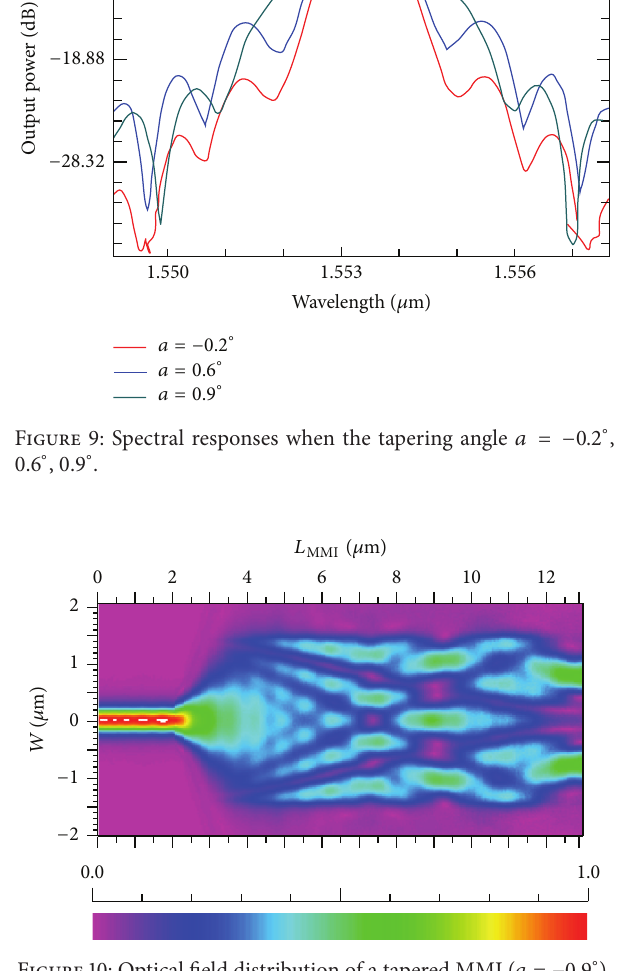
Figure 7: Crosstalk as the tapering angle 𝑎 varies.